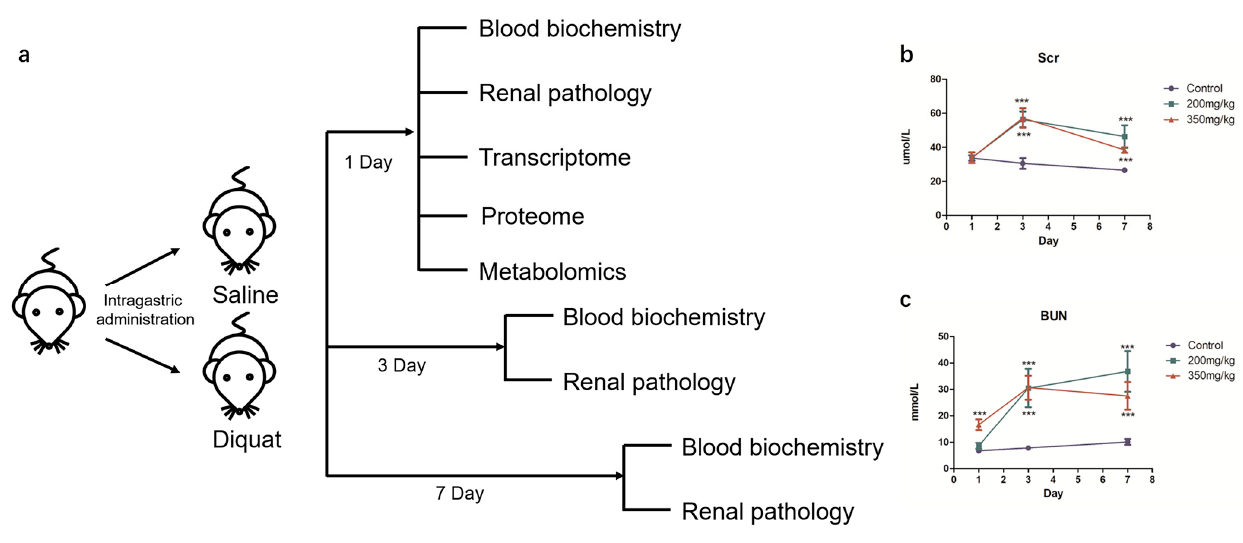
Figure 1. Establishment and validation of DQ-treated mice. ( a ) Outline of animal experiments. ( b ) The concentration of Scr ( ∗∗∗ p < 0.001). ( c ) The concentration of BUN ( ∗∗∗ p < 0.001).